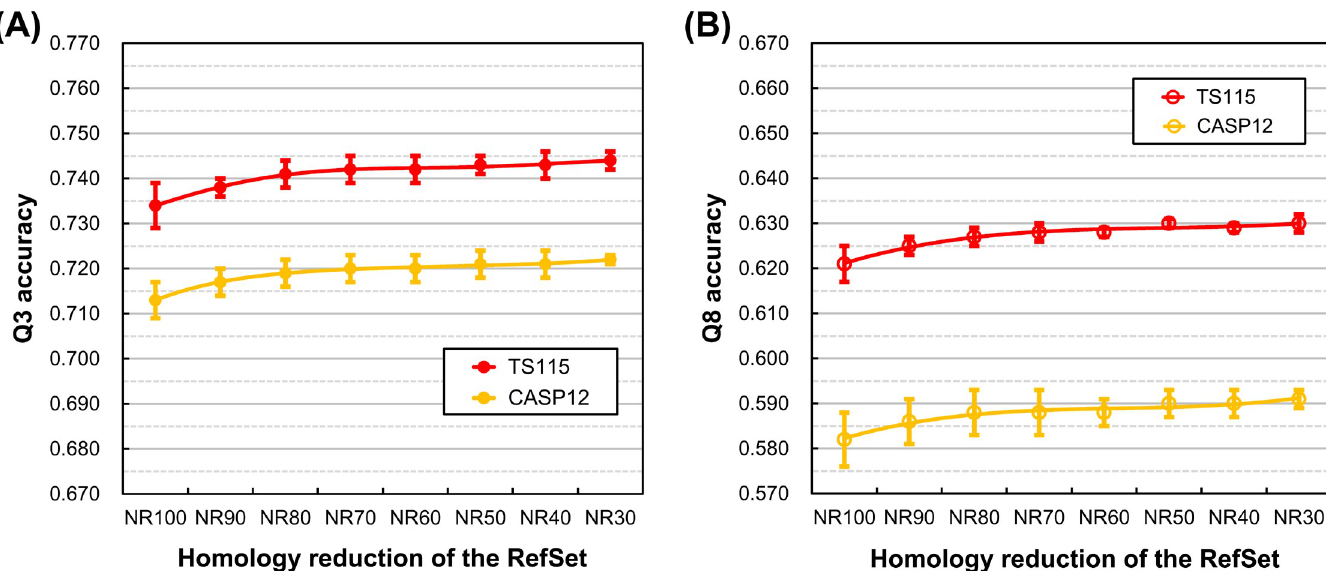
Fig 6. Accuracy of seven state-of-the-art secondary structure prediction methods evaluated using homology reduced PSSM reference datasets. (A) The average three-state SSP accuracy of state-of-the-art methods. (B) The average eight-state SSP accuracy of state-of-the-art methods. Advanced SSP methods including three-state algorithms PSIPRED [27], Scorpion [32], Spider2 [33] and SpineX [31], as well as eight-state DeepCNF [35], RaptorX [30], and SSpro8 [29] were utilized. The three-state test (A) was performed using all methods, and the eight-state test (B) was performed using eight-state algorithms. The query sets were independent test datasets TS115 and CASP12. The source of reference sequences was the UniRef of 2015. In addition to homology reduction, the reference dataset’s size was fixed at one million sequences by random sampling in each test group. With random sampling, for each SSP method, the experiment was repeated five times to obtain the average and standard deviation of its accuracy at all homology levels. Finally, the statistics of the tested methods were averaged. The results reveal that the homology reduction of PSSM reference sequences can raise the practical accuracy of SSP methods.